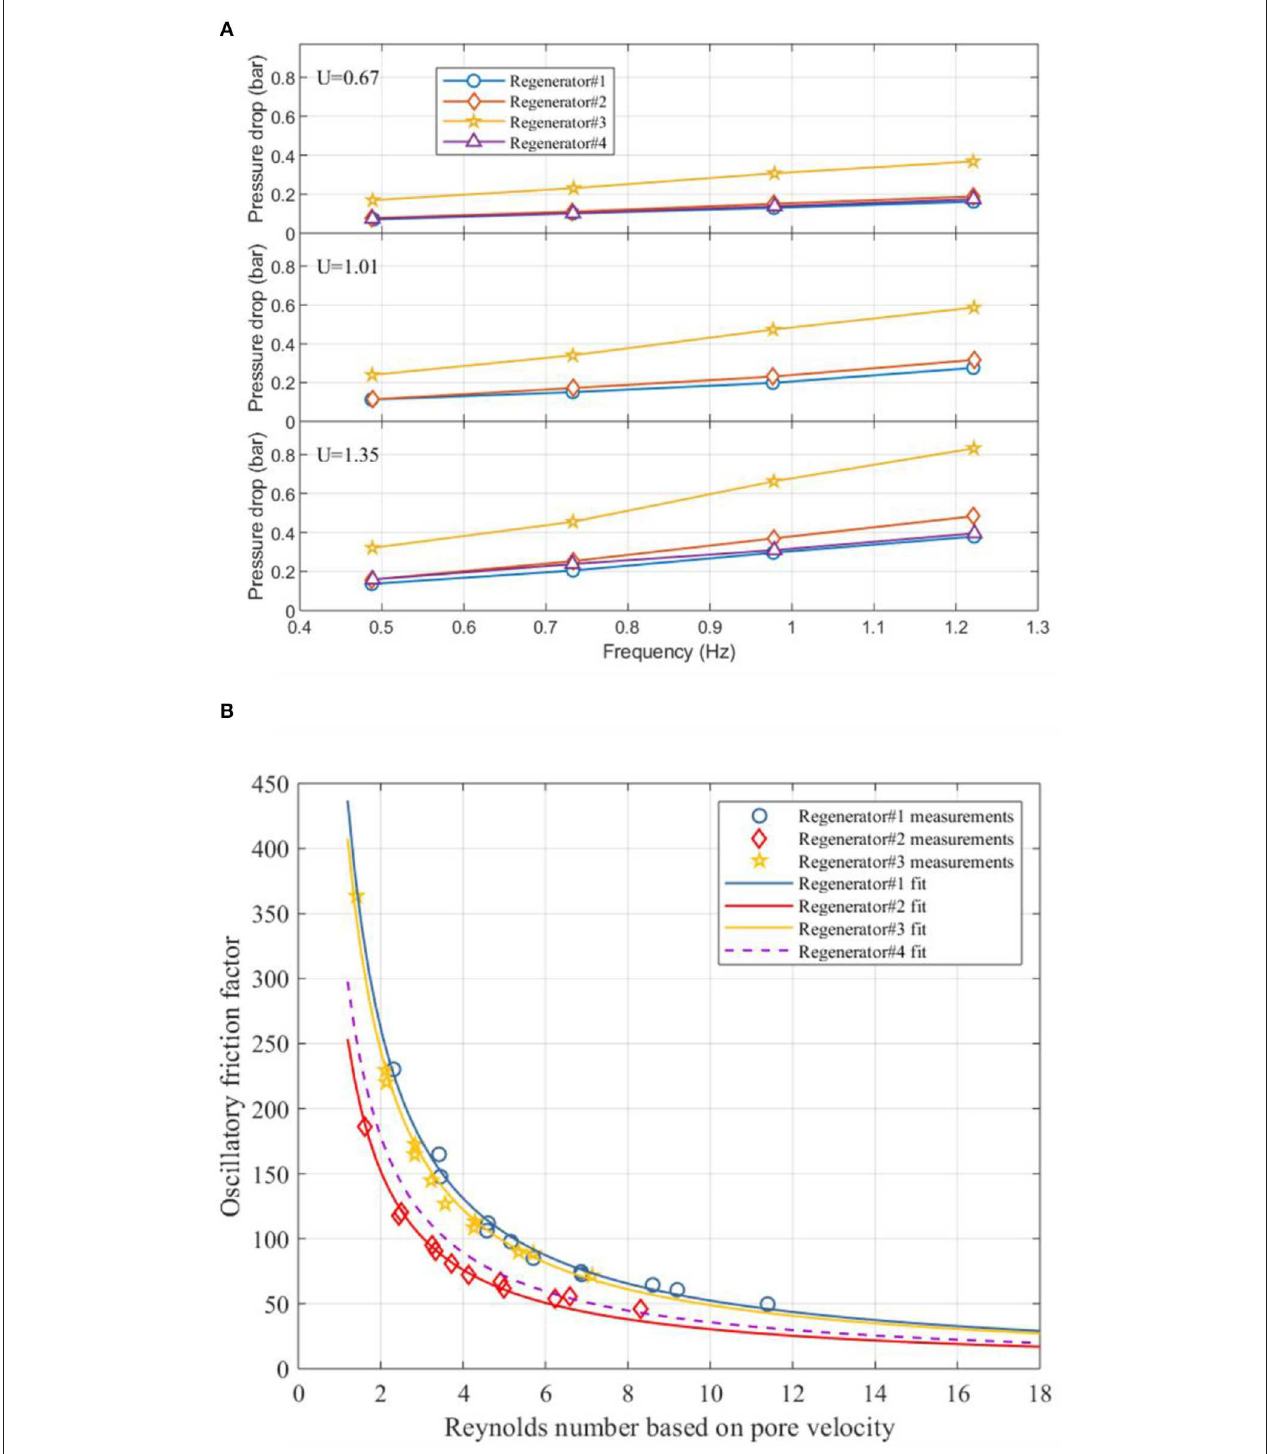
FIGURE 5 | (A) Pressure drop amplitude as a function of frequency and (B) oscillatory friction factor as a function of pore Reynolds number under different utilizations. All the regenerators are measured based on the same manifold and hydraulic system in the passive rig. All the regenerators have nearly the same sample porosity, macro porosity and shape. Note that there is 10% reduction of the length of regenerator #4 due to practical reasons. The data for regenerator #4 are derived from ∼ Liang et al. (2020).